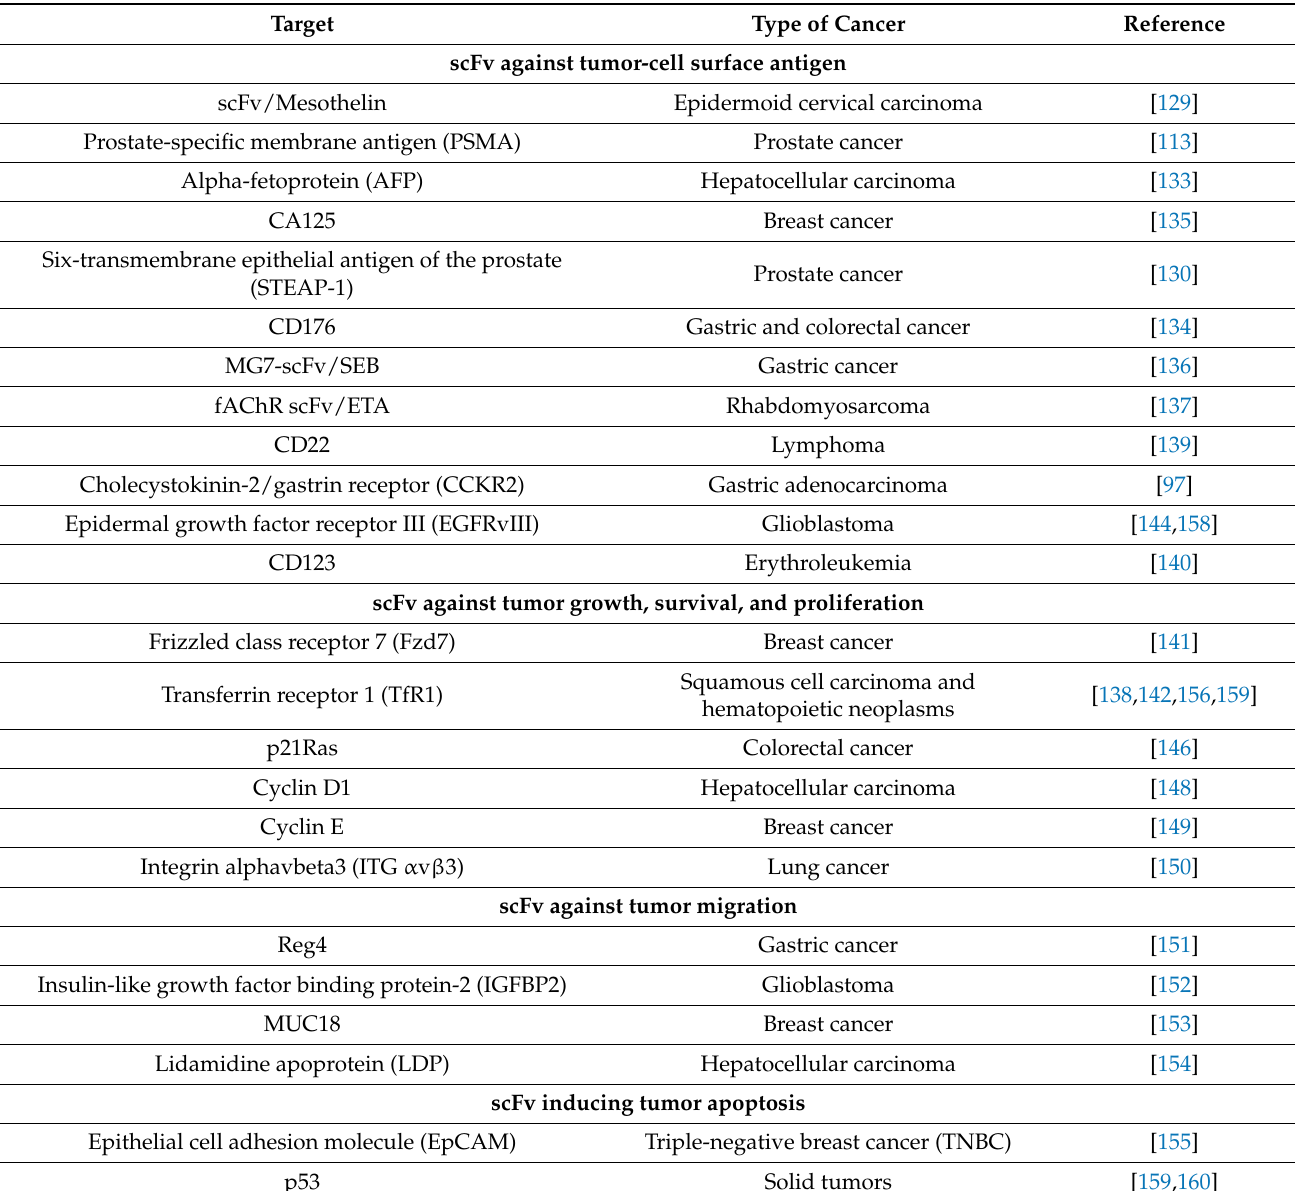
Table 2. scFvs as cancer